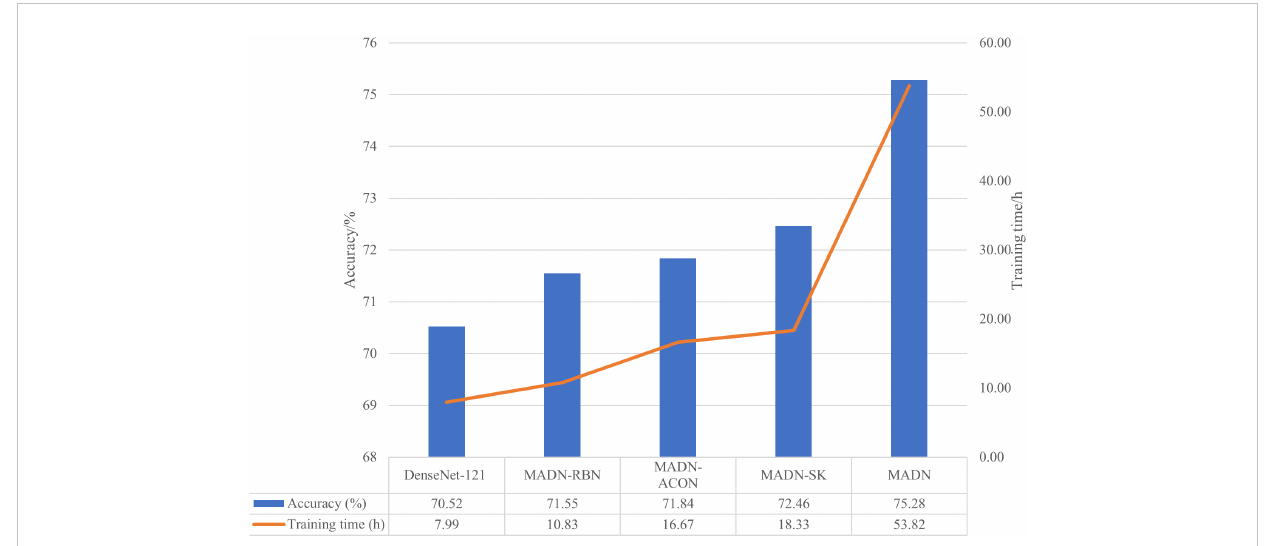
FIGURE 5 Comparison of training time and test set accuracy for DenseNet-121 and improved models.